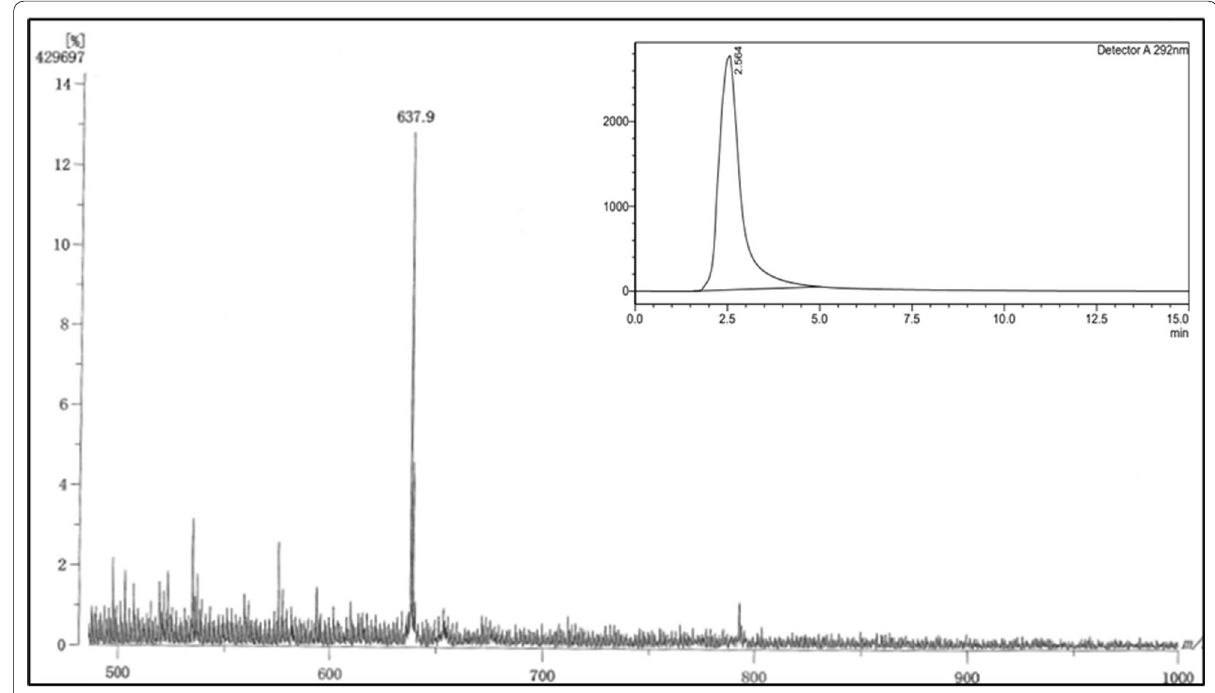
Fig. 1 Mass spectra of the T. chebula water extract. (inset) The HPLC spectra of purified Fe 2 + and Fe 3 + active T.